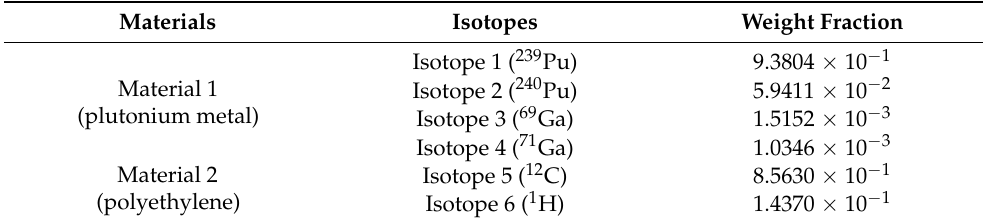
Table 1. Dimensions and composition of the PERP